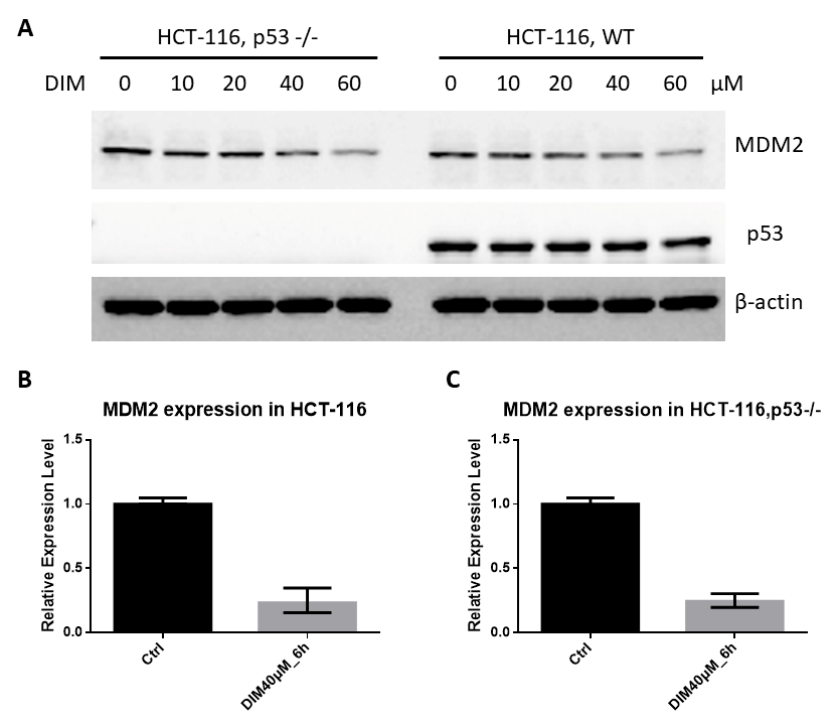
Figure 3. DIM inhibited MDM2 independent of p53. ( A ) Wild-type HCT-116 and p53 knockout HCT-116 cells were treated with various doses of DIM for 24 h. The cell lysates were analyzed by Western blotting with the indicated antibodies. ( B ) Wild-type HCT-116 cells and ( C ) p53 knockout HCT-116 cells were treated with 40 µ M of DIM for 6 h. Real-time polymerase chain reaction (PCR) analysis of MDM2 gene expression was conducted as described in Materials and Methods.